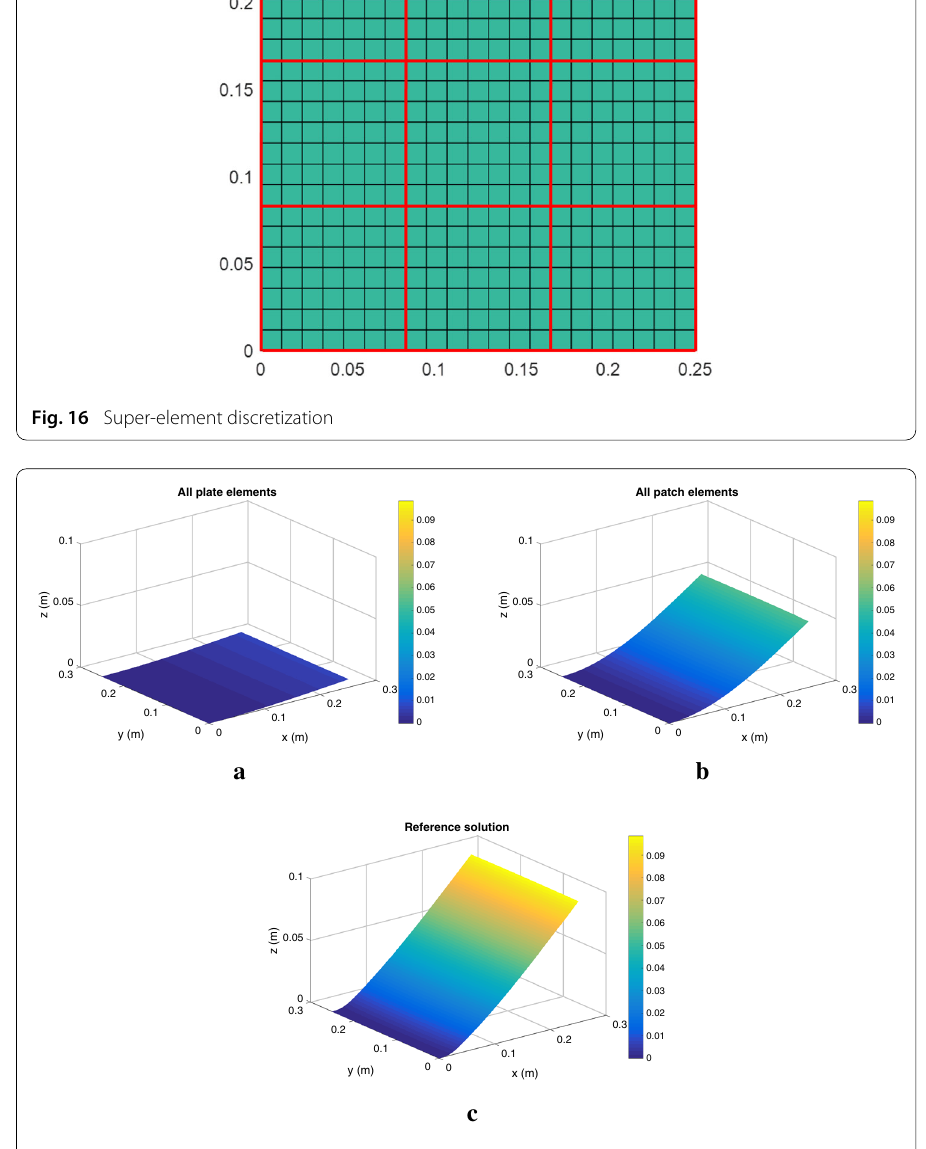
Fig. 17 Plate theory displacement ( a ), all patch elements according to Fig. 16 ( b ) and refined 3D FEM (reference solution) ( c )